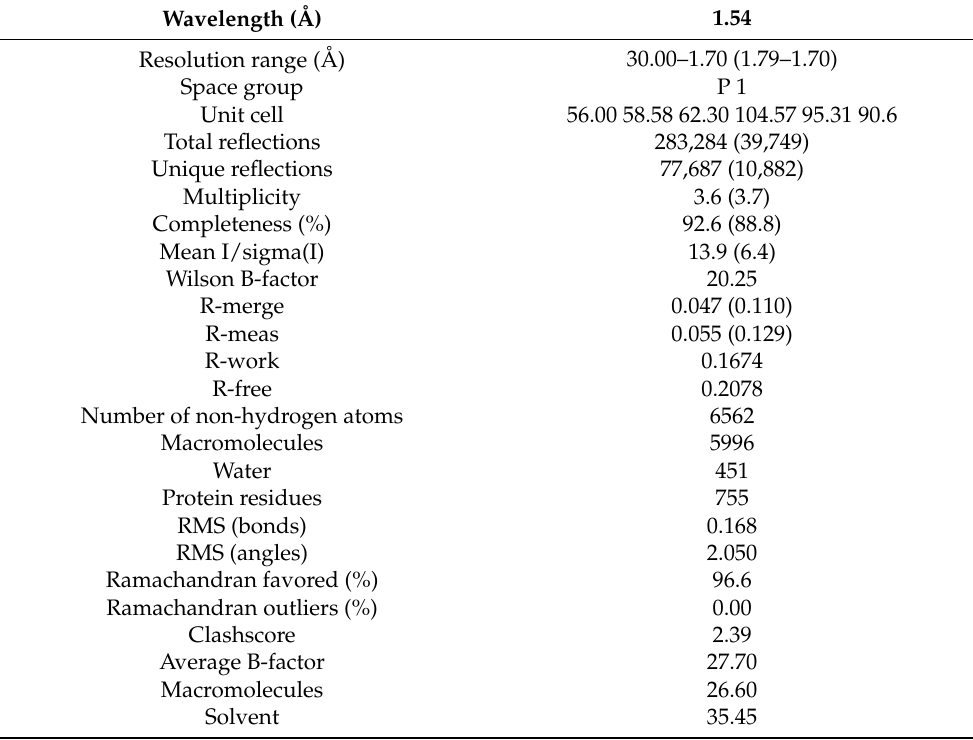
Table 2. Crystallographic data collection and refinement